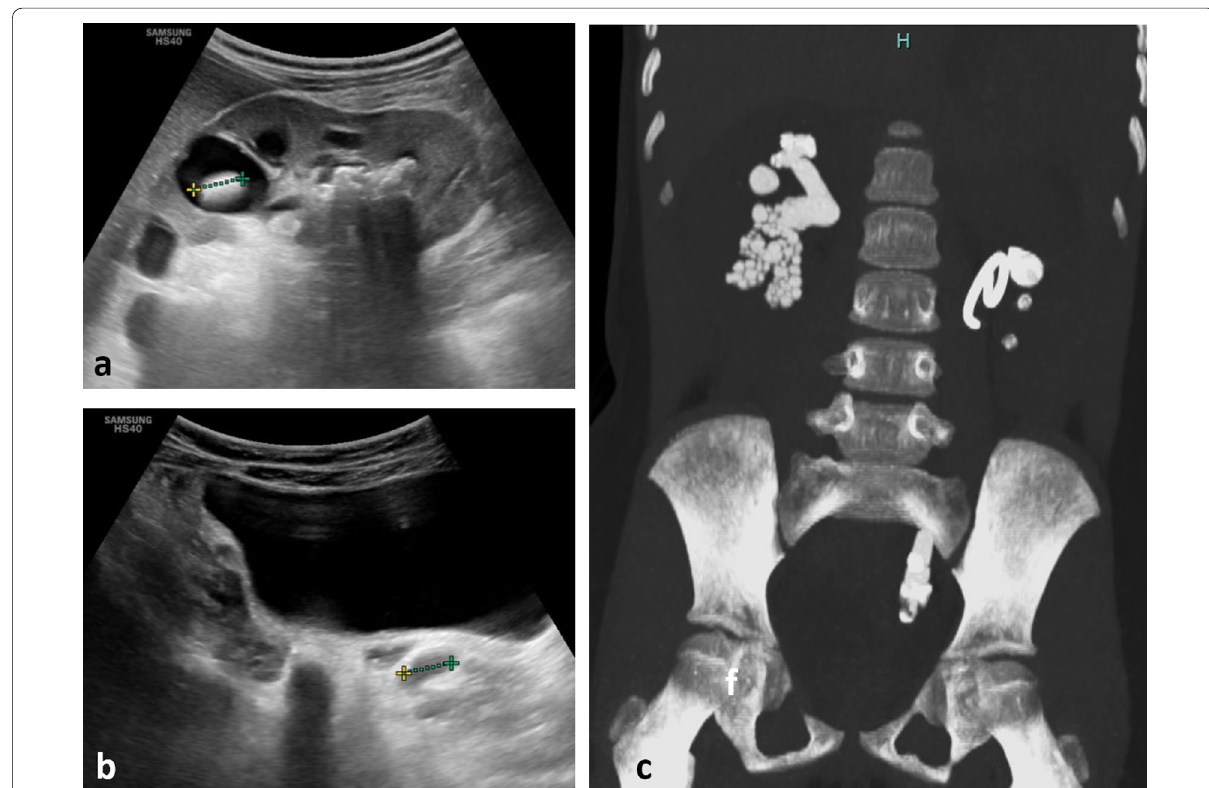
Fig. 12 8-year-old girl with multiple stones a renal ultrasound reveals multiple stones filling the calyces and renal pelvis appears as dense echogenic foci with acoustic shadowing. b longitudinal ultrasound through the pelvis shows multiple stones at the distal ureter as well. Owing to complexity of the case, c non-contrast CT of the urinary tract is requested prior to surgical intervention and reveals multiple bilateral renal and left ureteric